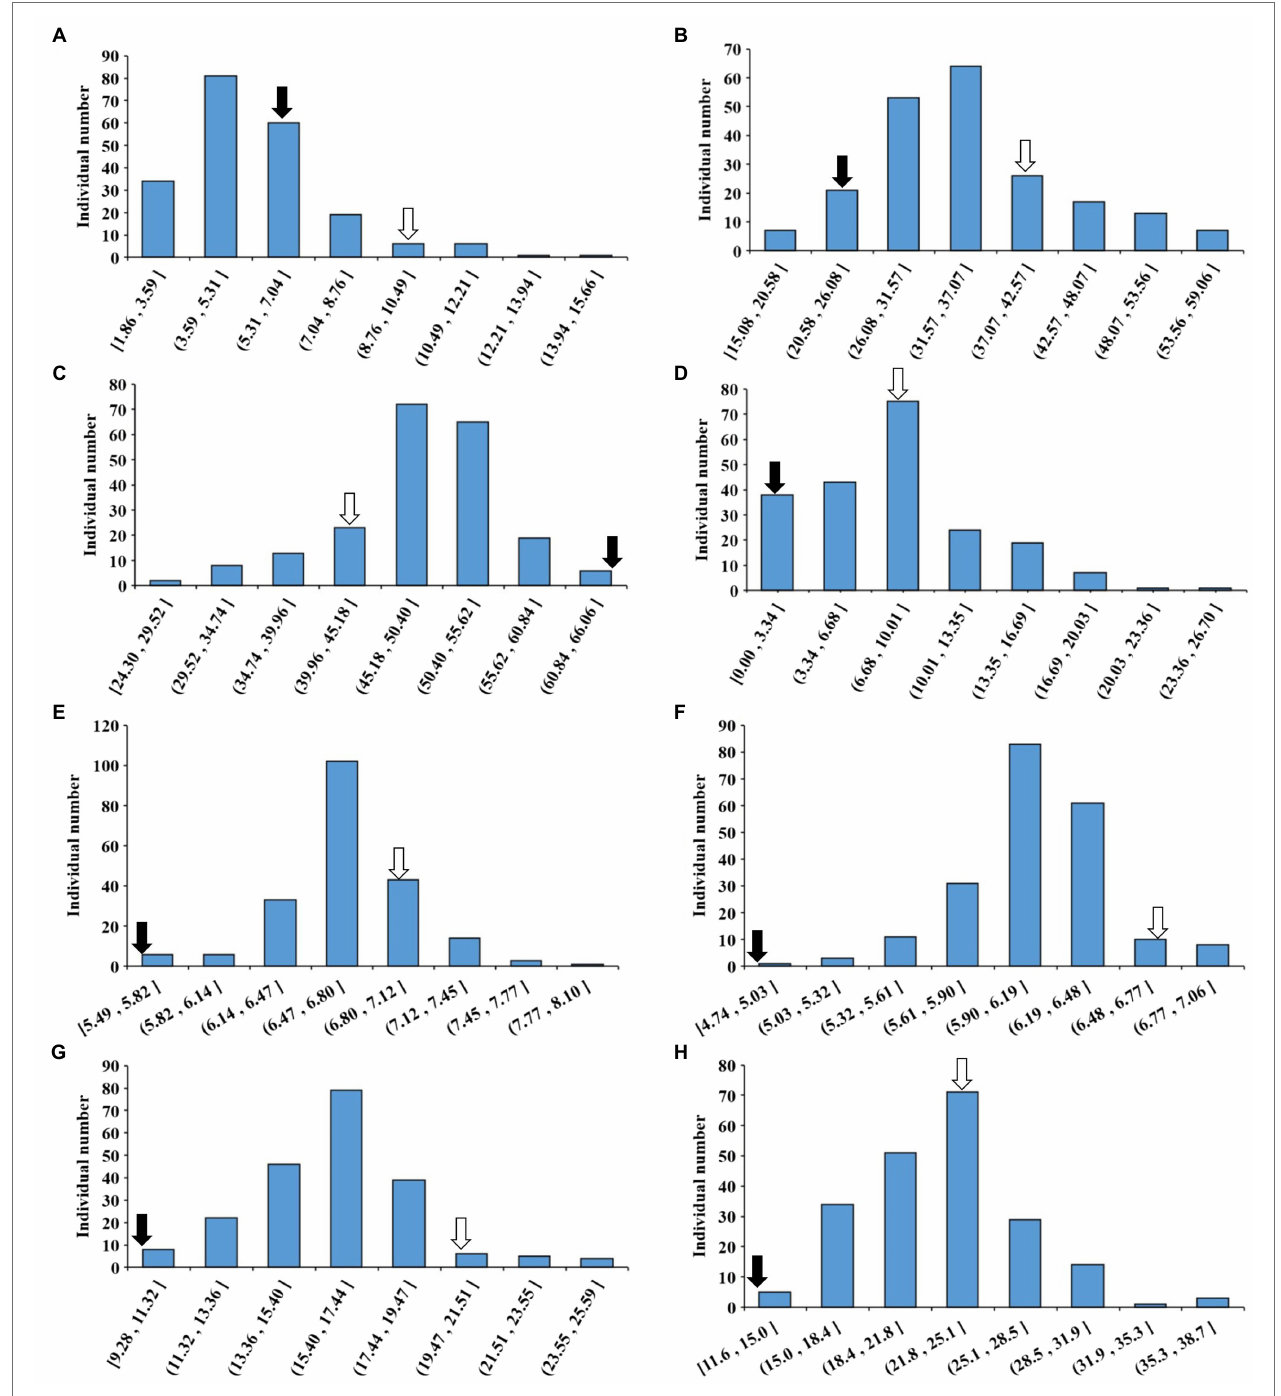
FIGURE 2 | Phenotype of CSSLs seed-pod characteristics in BLUE. (A) The BLUE value of PoOSPN (%); (B) The BLUE value of PoTSPN (%); (C) The BLUE value of PoTHSPN (%); (D) The BLUE value of PoFSPN (%); (E) The BLUE value of SL (cm); (F) The BLUE value of SW (cm); (G) The BLUE value of HSW (g); (H) The BLUE value of SPW (g). ⇒ : Suinong14, ➡ :